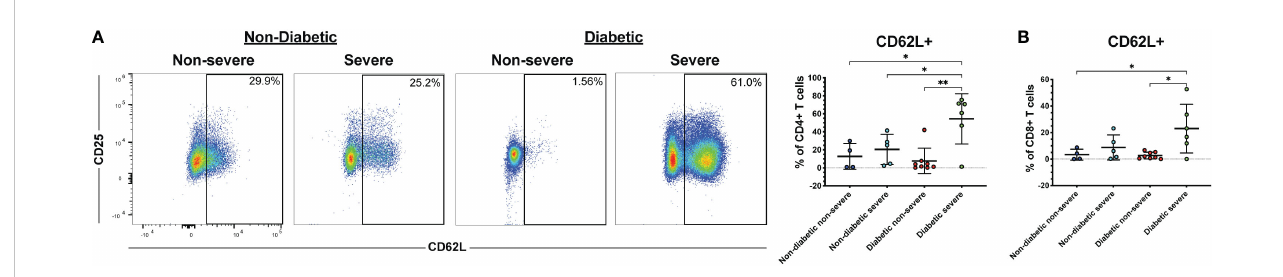
FIGURE 5 Diabetic severe COVID-19 patients have greater frequencies of CD62L+ T cells. The frequencies of CD4+ (A) and CD8+ T cells (viable, CD14-, CD56-, CD19-, CD3+, CD4+ or CD8+ cells) (B) expressing CD62L in severe and non-severe COVID-19 patients with or without diabetes were assessed by fl ow